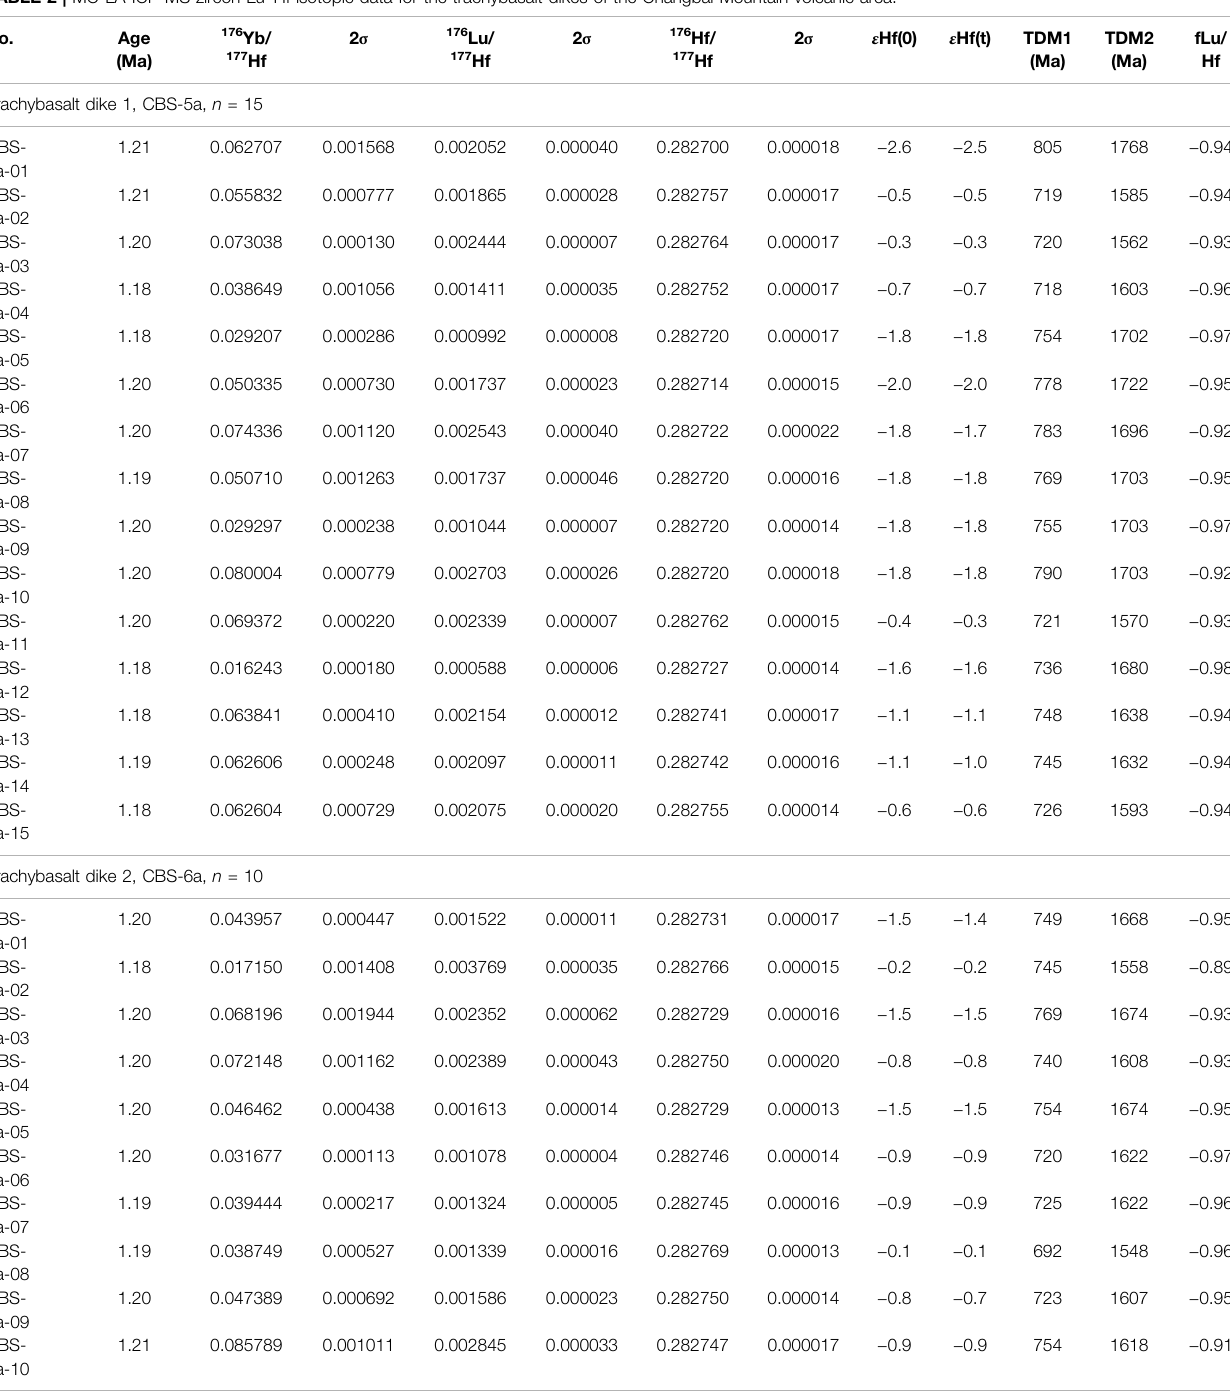
TABLE 2 | MC-LA-ICP-MS zircon Lu – Hf isotopic data for the trachybasalt dikes of the Changbai Mountain volcanic